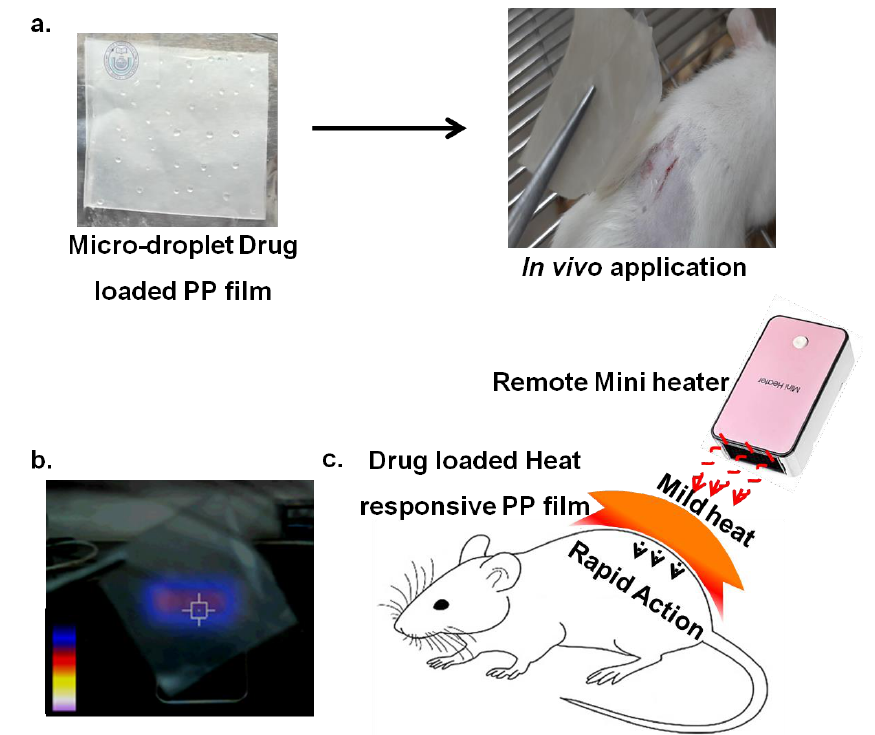
Scheme 1. ( a ) Image of microdroplet drug (lidocaine) solution on PP film (1 inch × 1 inch),